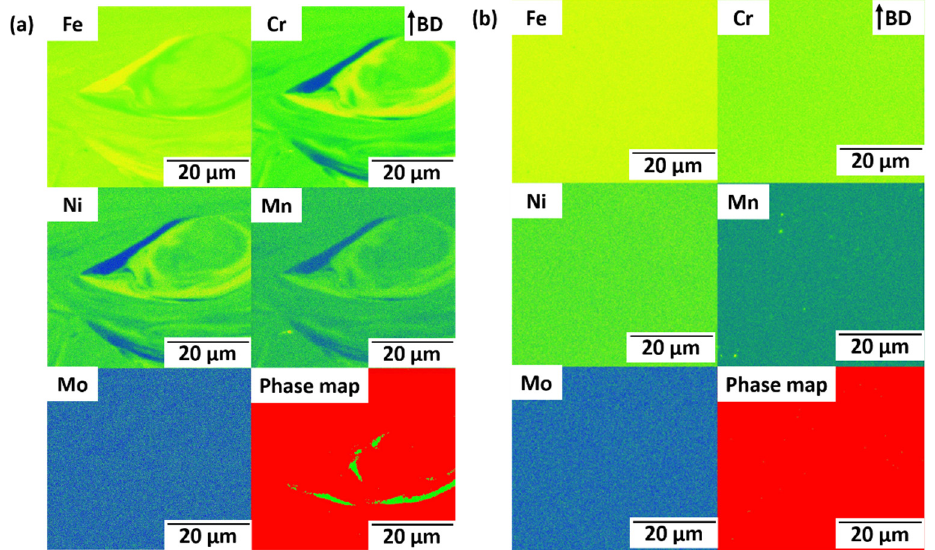
Figure 10. Elemental chemical mapping showing the distribution of Fe, Cr, Ni, Mn, Mo and α / γ (phase map) for the ( a ) as-built and ( b ) heat-treated samples. In the phase map, the red colour represents α , and the green colour represents γ .